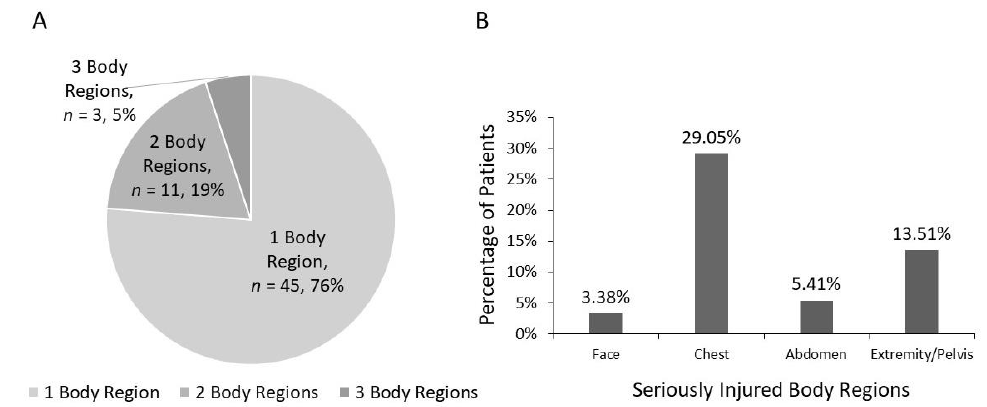
Figure 2. ( A ) The number of body regions with serious extracranial injuries ( B ) The distribution of seriously injured body regions.